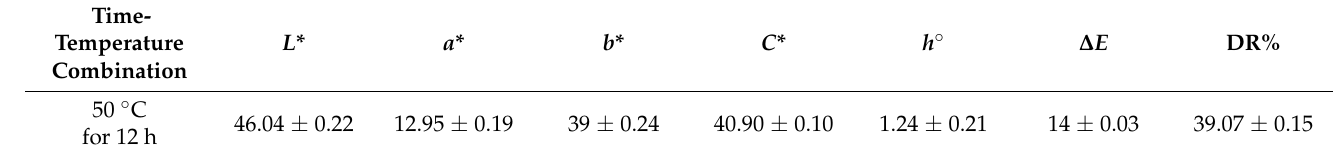
Table 3. Results of the analyses of CIE L * a * b * coordinates, with values of chroma ( C *), hue angle ( h ◦ ), color variation ( ∆ E ), and drying efficiency (DR%). Values represented as mean ±